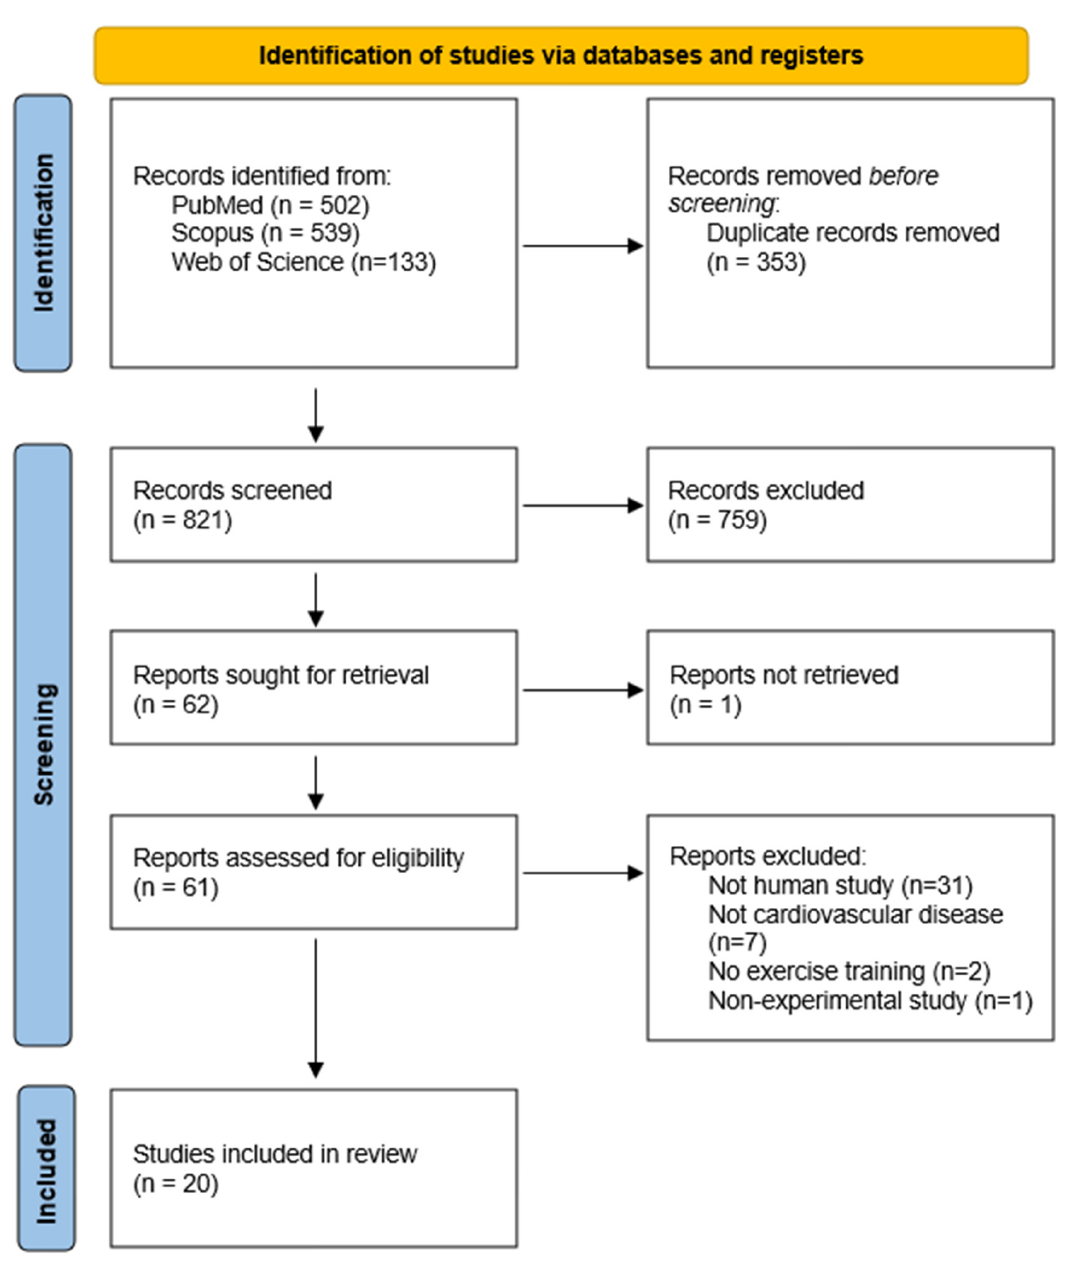
Figure 1. PRISMA flow diagram of the study. Review papers, animal studies, non-experimental studies, studies involving subjects with hereditary disease, studies with only one bout of exercise, and articles written in languages other than English, or have no available full text, were excluded.